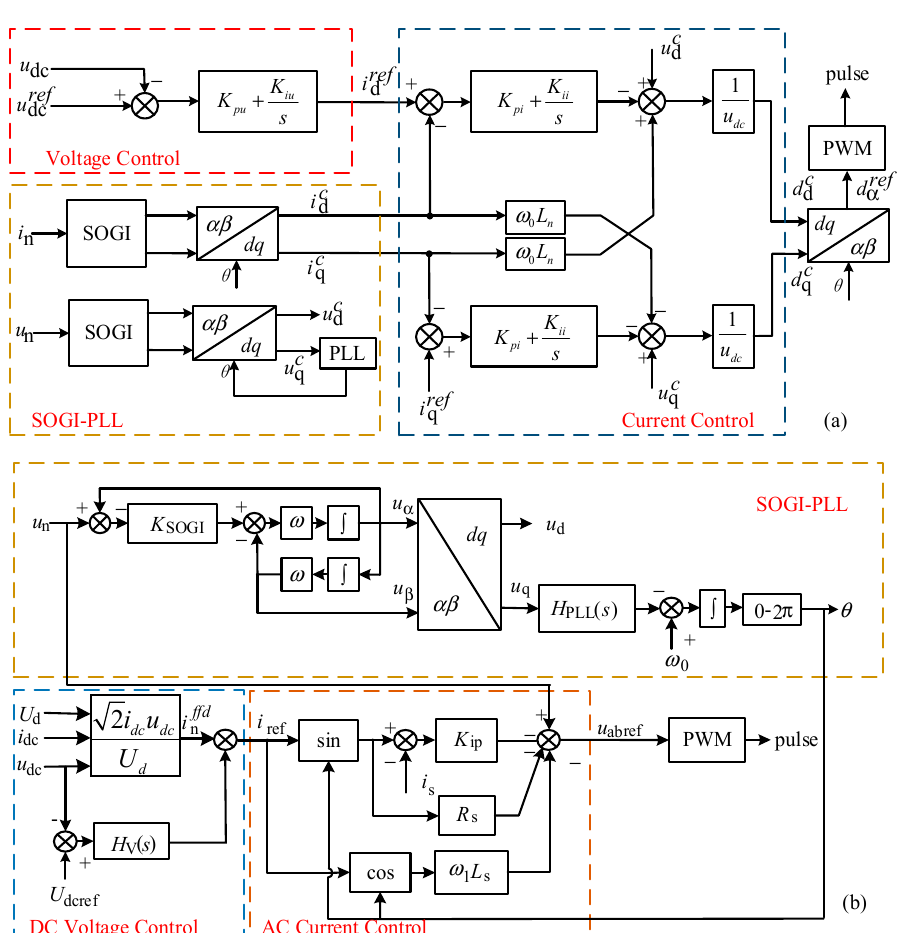
Figure 2. ( a ) Control structure of the rectifier in CRH5. ( b ) Control structure of the rectifier in HXD 2B .